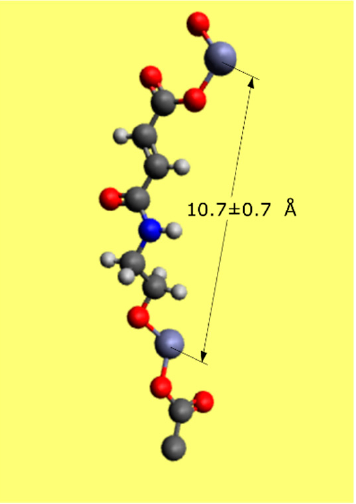
Figure 7. Monolayer molecule geometry simulated via Avogadro yielding a distance of 10.7 ± 0.7 Å between two consecutive Zn atoms.